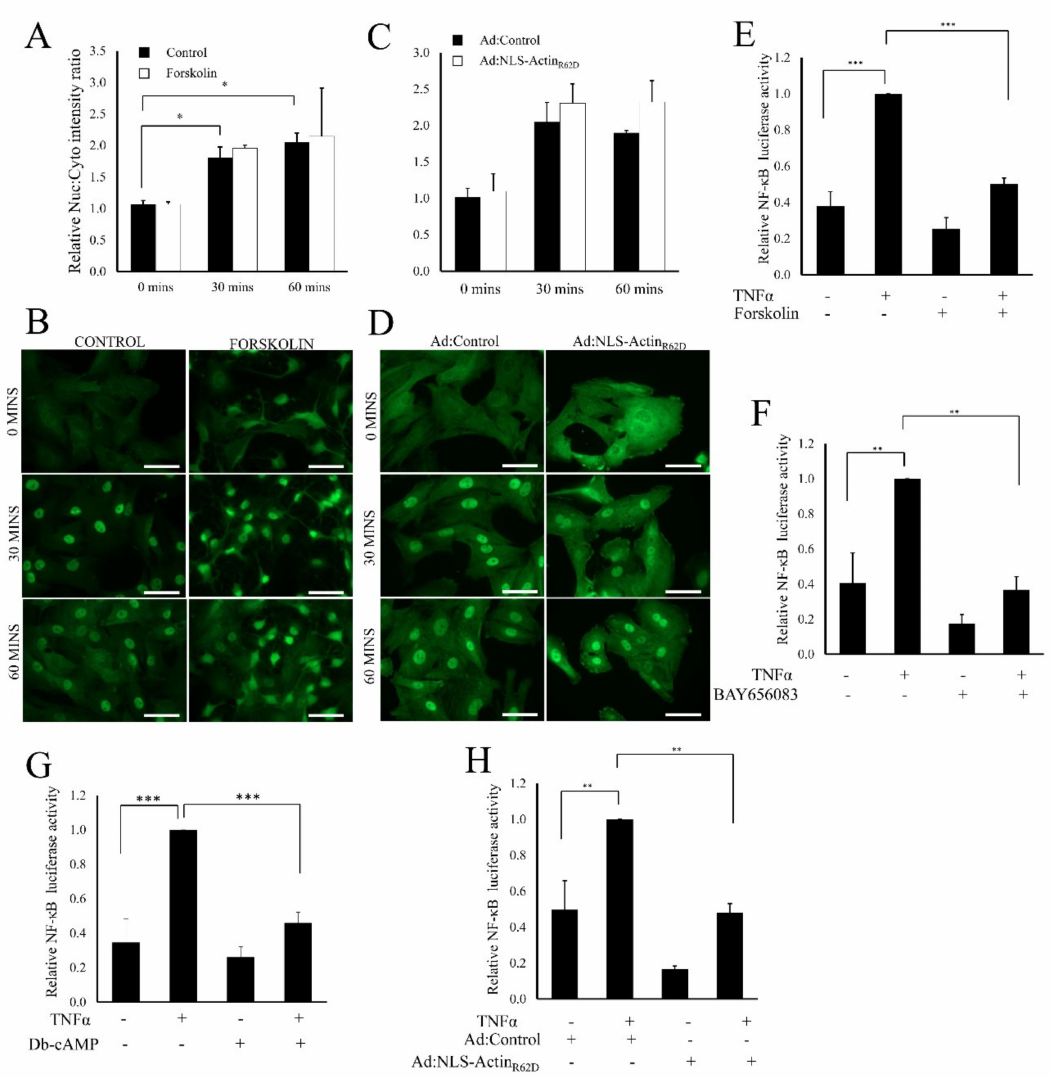
Figure 5. Cyclic-AMP and nuclear actin monomers attenuate TNF α -induced NF- κ B activity without impairing RelA/p65 nuclear translocation. Serum starved VSMCs were pre-treated with 25 µ M forskolin for 1 h prior to TNF α stimulation for the indicated times ( A , B ). Cells were infected with control adenovirus (Ad:Control) or virus expressing NLS-Actin R62D (Ad:NLS-Actin R62D ) 24 h before TNF α stimulation ( C , D ). Cytoplasmic:nuclear ratios of RelA/p65 staining intensity was quantified (( A , C ); n = 3). Cells were transfected with the NF- κ B reporter plasmid (NF- κ B-LUC). Serum starved cells were treated with forskolin (( E ); n = 4), BAY60-6583 (( F ); n = 4) or Db-cAMP (( G ); n = 4) for 1 h before TNF α stimulation for a further 6 h. Cells were transfected with NF- κ B-LUC and subsequently infected with either Ad:Control or Ad:NLS-Actin R62D . Cells were stimulated with TNF α for 6 h before NF- κ B reporter activity was quantified (( H ); n = 5). ANOVA with Student Newman Keul’s post hoc test. Data are mean ± SEM. *, ** and *** indicate p < 0.05, 0.01 and 0.001,